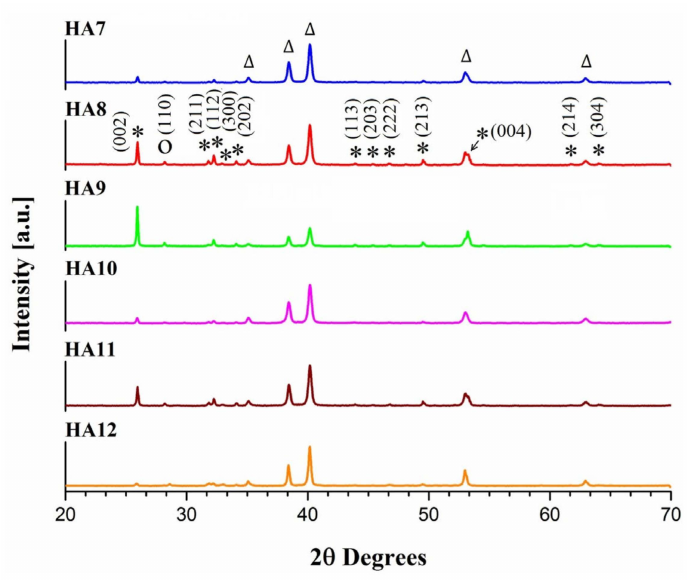
Figure 3. XRD patterns obtained for the HA7-HA12 samples, electrodeposited at 90 ◦ C. The ∆ symbol indicates the diffraction peaks corresponding to the Ti support. The O symbol indicates the diffraction peak possibly corresponding to octacalcium phosphate (OCP). The peaks that belong to HA are marked with